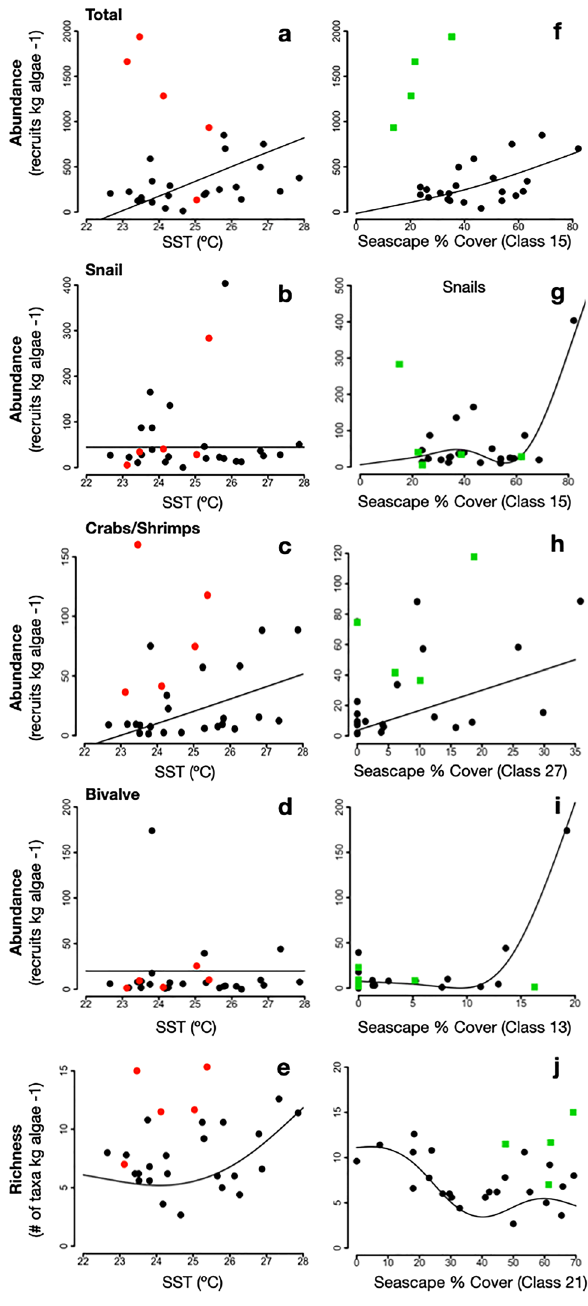
Figure 3. Results of the generalized linear models to examine SST ( a – e ) and local Seascape % cover ( f – j ) as predictors of temporal changes in recruitment (black dots, May 2017 to April 2019) and the observed patterns for the following months (red dots and green squares, July to November